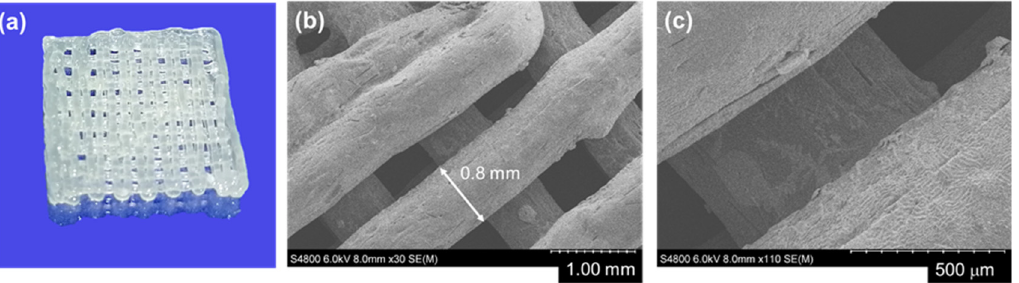
Figure 4. ( a ) Digital picture and ( b , c ) SEM images of the scaffold printed with a nozzle of 0.8 mm at a magnification of × 30 ( a ) and × 110 ( b